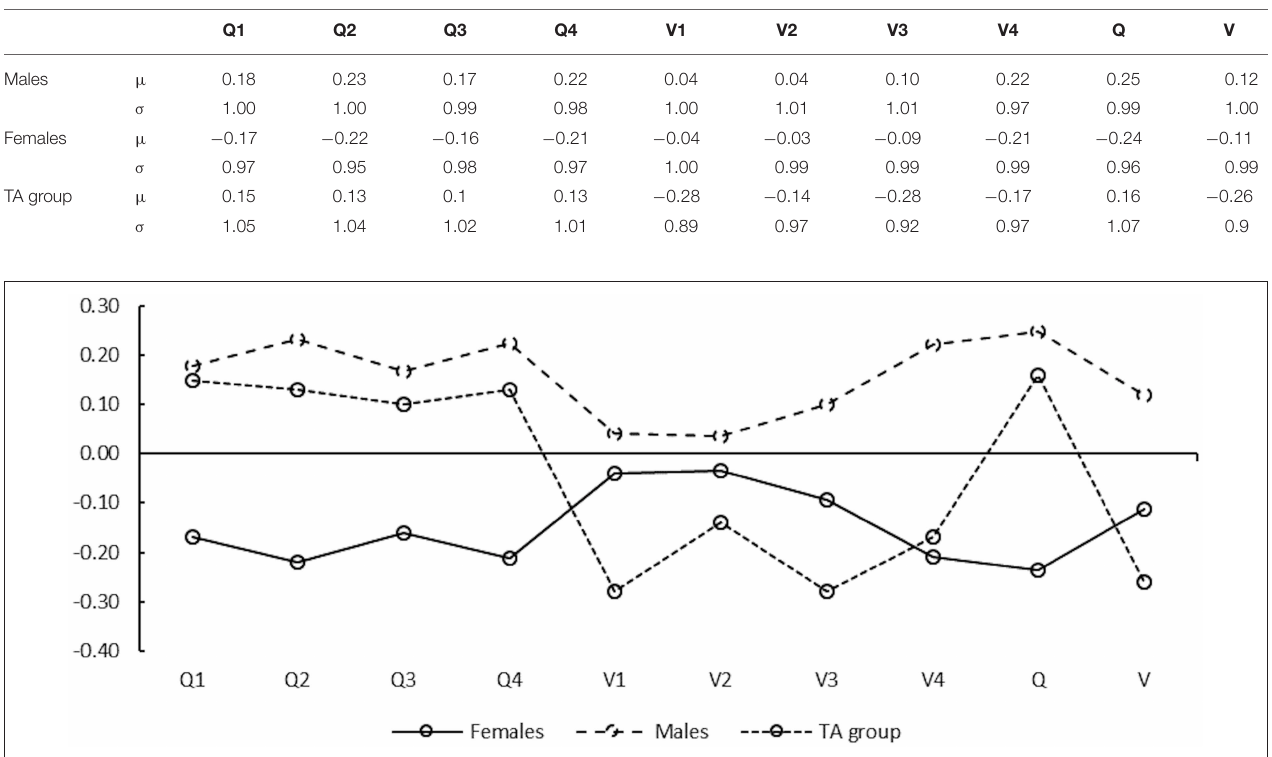
TABLE 3 | Standardized subscore means and standard deviations for males ( N = 37,432) and females ( N = 39,516) and TA group ( N = 1,641) for test administration 16A (the results from 16B shows an equal pattern).